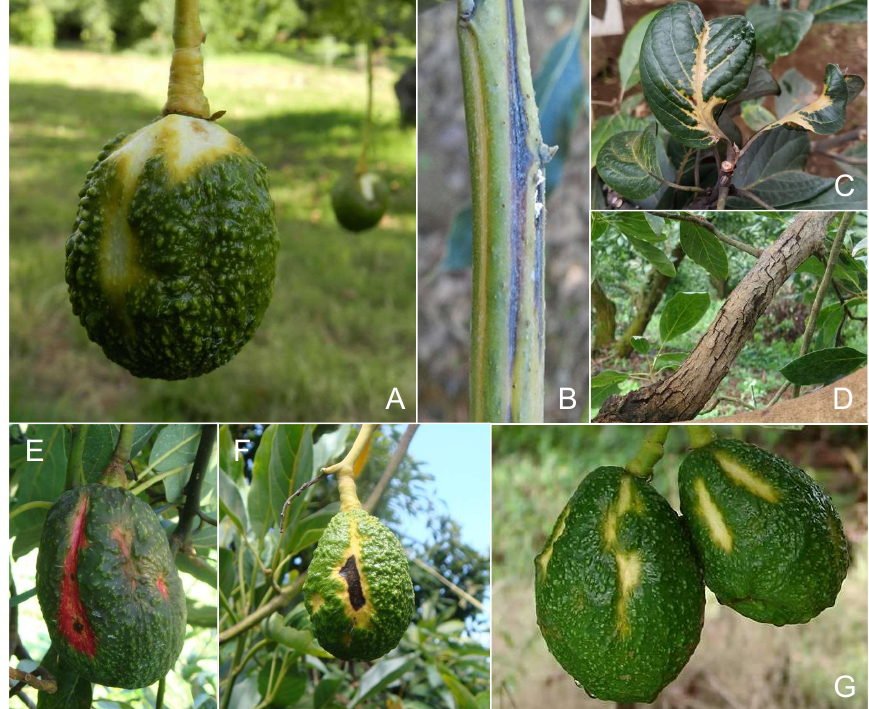
Figure 2. Symptoms of avocado sunblotch disease. Yellowish sunken areas on fruits ( A ); discolored and necrotic depressions on infected twigs ( B ); distortion and variegation on leaves ( C ); cracked bark (“Alligator skin”) appearance on some mature branches ( D ); fruits with reddish color areas ( E ); necrosis on severely affected fruits ( F ); multiple yellowish sunken areas in fruits ( G ).